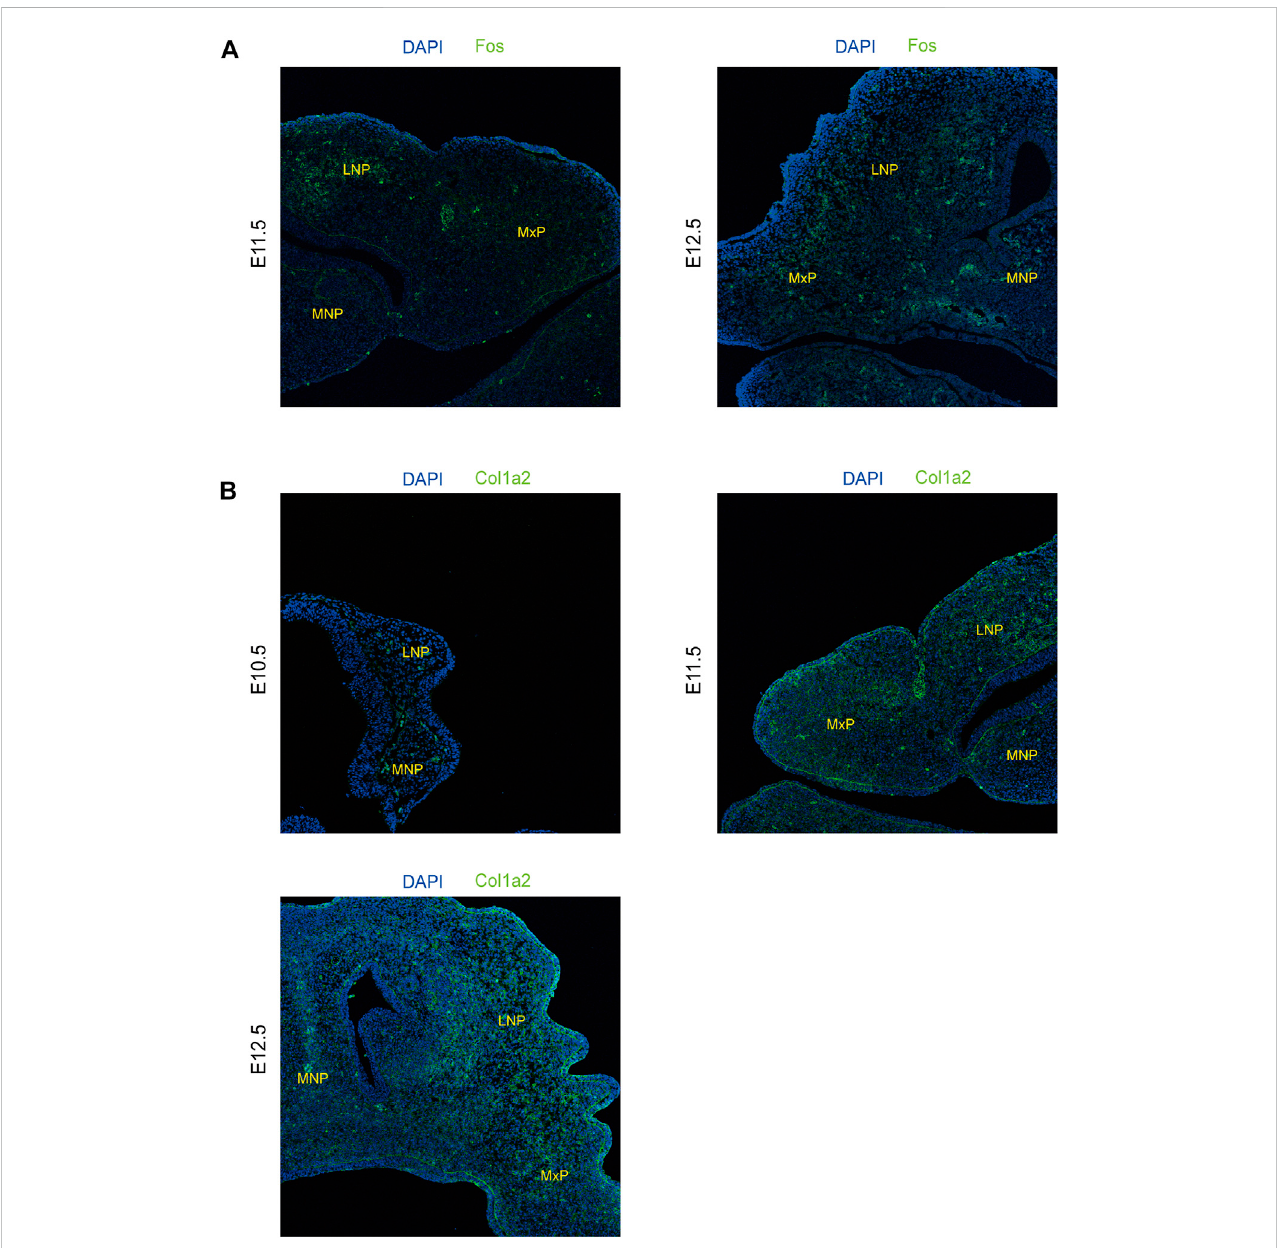
FIGURE 9 xpression levels of representative genes from the PPI network detected by immuno fl uorescence in lambdoidal junction tissues of mice at embryonic days 10.5, 11.5, and 12.5. (A) Expression levels of col1a2 at E10.5, E11.5, and E12.5. (B) Expression levels of Fos between E11.5 and E12.5. MxP: maxillary prominence; LNP: lateral nasal; MNP: medial